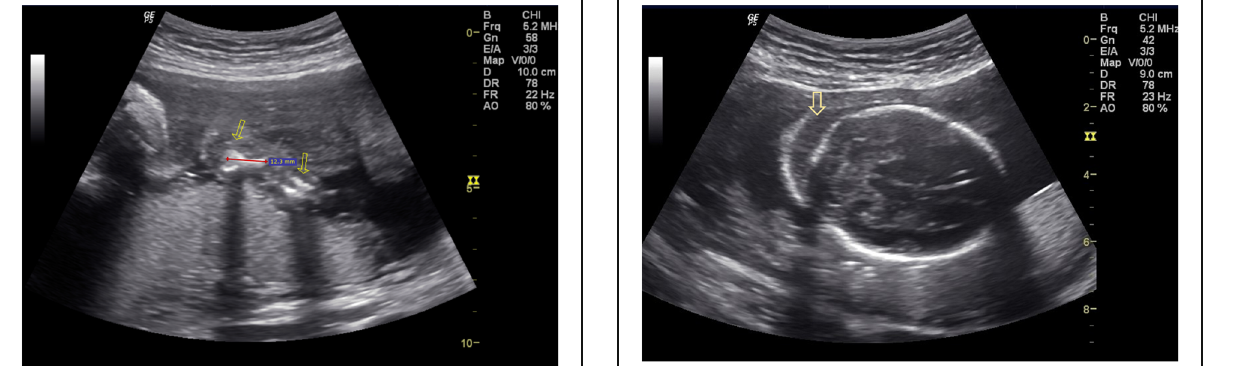
Fig. 1 Ultrasound image of the right lower limb of the fetus in a longitudinal plane shows severe micromelia with shortening of the femur, tibia, and fibula (arrows). The femoral length corresponds to 13 weeks 4 days period of gestation